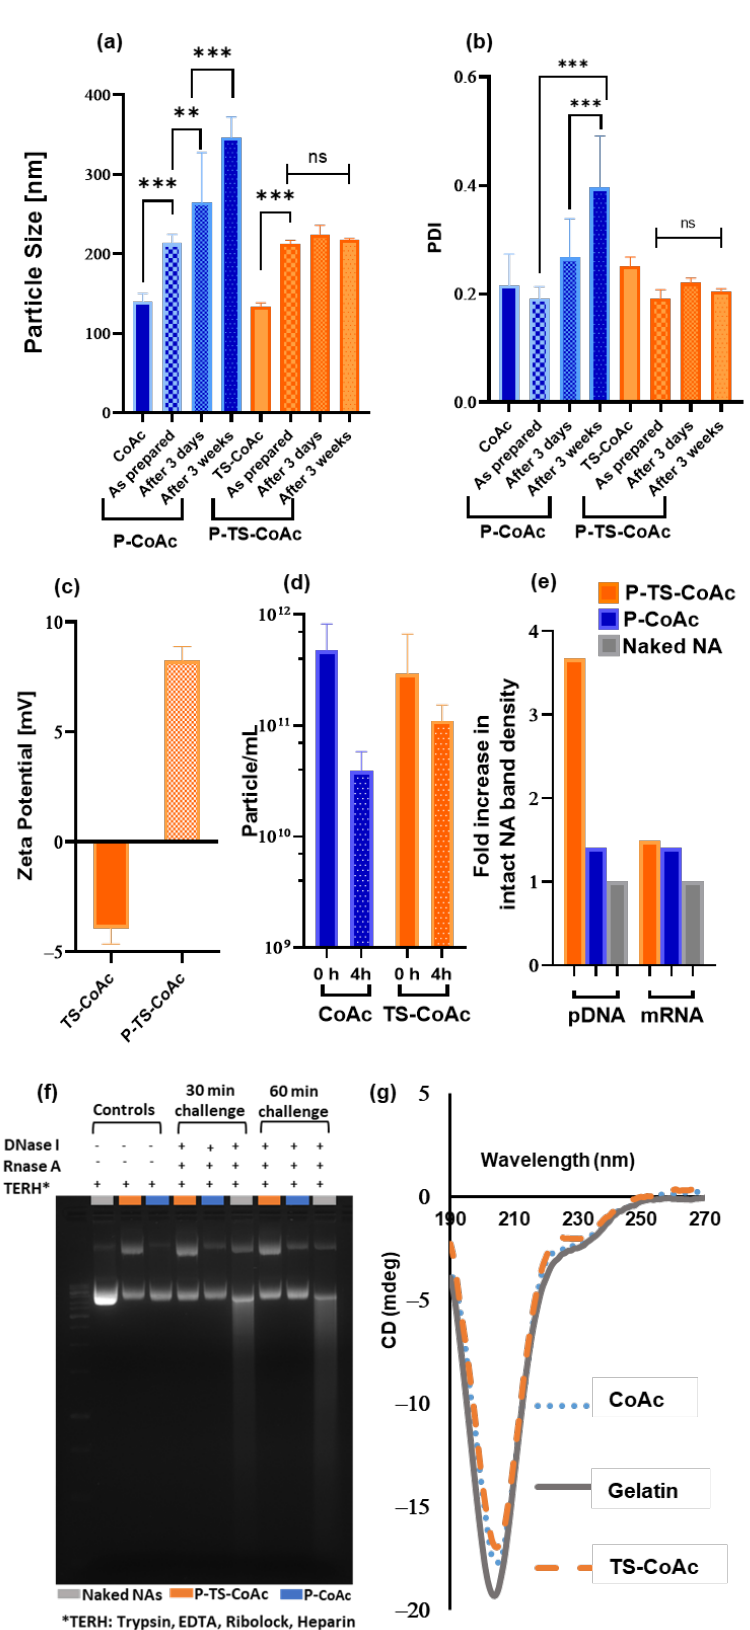
Figure 3. Assessment of the impact of thermal stabilization on particle stability after protamine sulfate coating with gelatin to protamine sulfate ratio of 5:1 ( w / w ). ( a ) Particle size (hydrodynamic di- ameter, nm) and ( b ) PDI of CoAc and TS-CoAc before and immediately after protamine sulfate